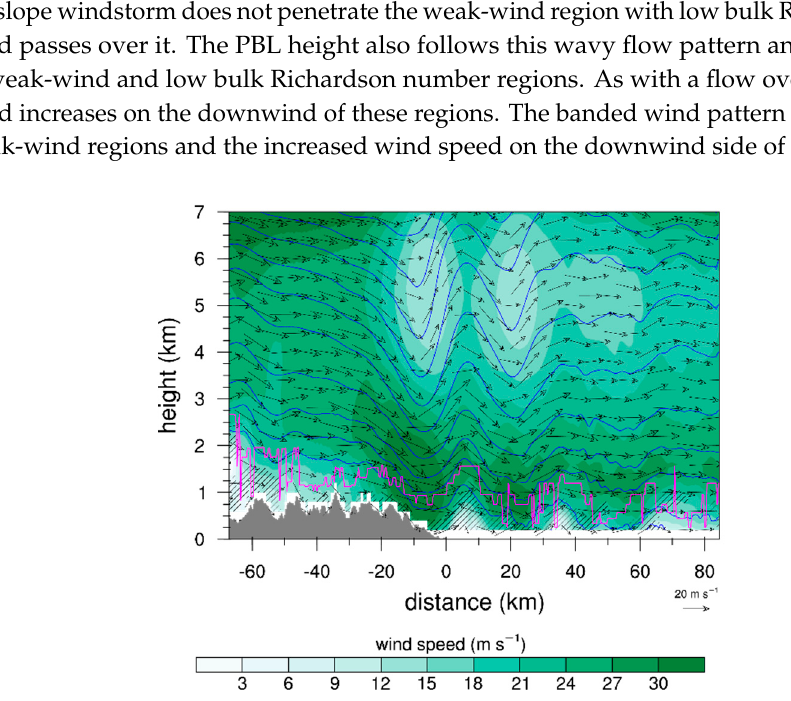
Figure 12. Vertical cross-section of the wind speed, wind vector, potential temperature (blue lines), and bulk Richardson number smaller than 0.25 (black hatch lines) along C2 at 1800 LT. The PBL height is represented by magenta line. The reference point on the horizontal axis (0 km) indicates the location of Uljin station.